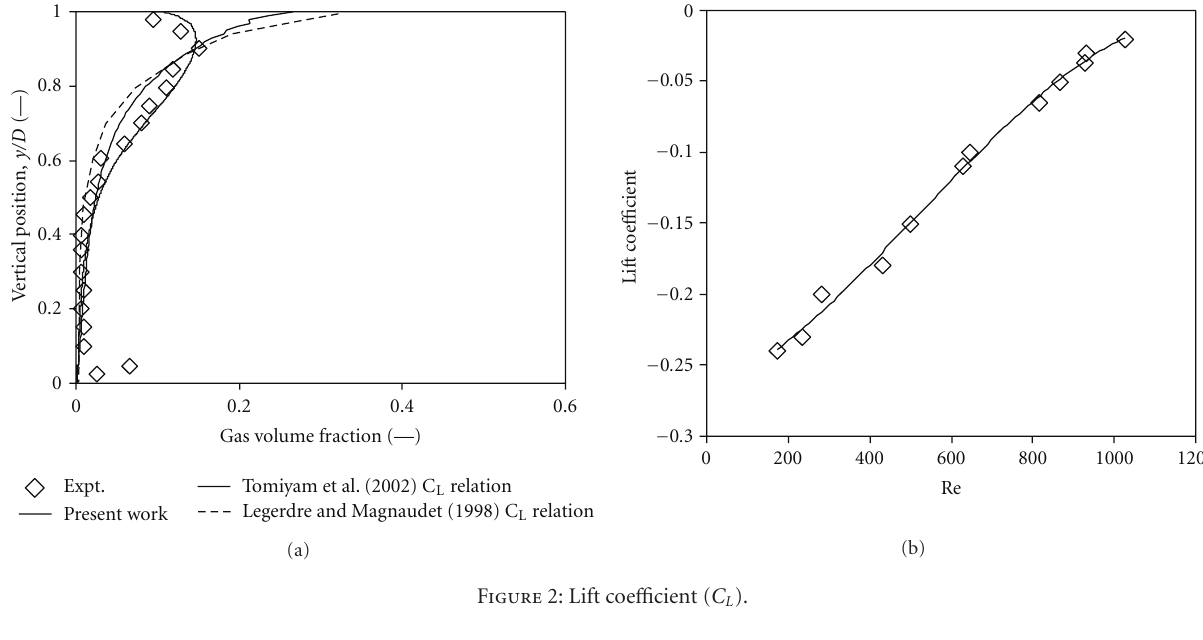
Figure 2: Lift coe ffi cient ( C L ).